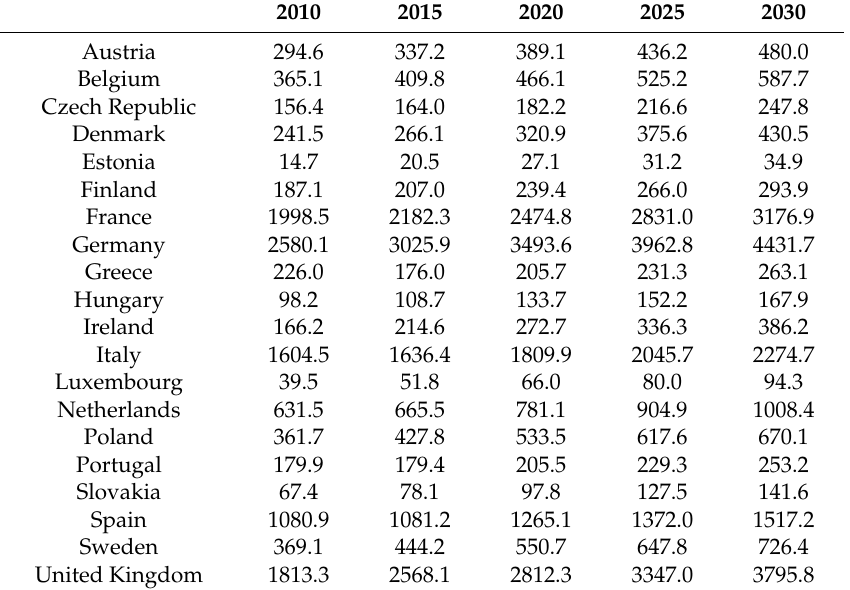
Table 2. The expected development of IEA/EU member countries’ GDP in billion EUR by 2030 is based on OECD [23]; exchange rates of non-Eurozone countries are based on Eurostat